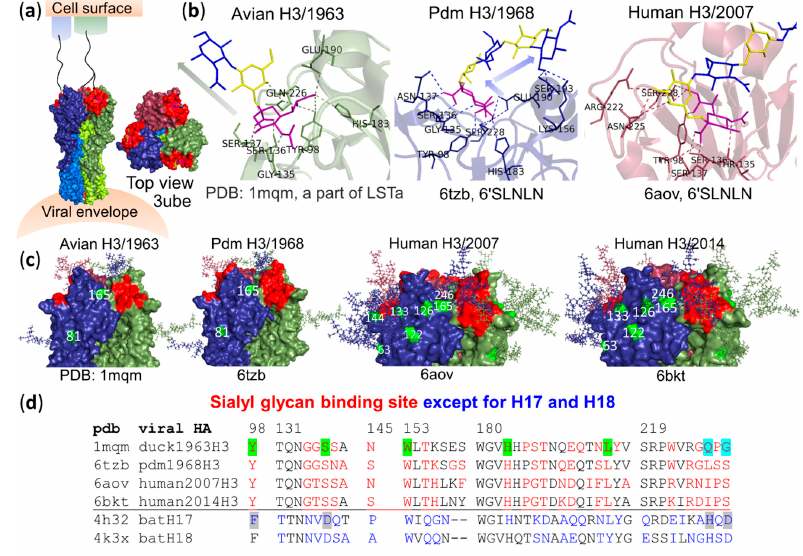
Figure 3. Binding of avian, pandemic (pdm) and seasonal HAs to specific sialyl glycans. ( a ) HA trimer binding to sialyl glycan receptors on the host cell surface. ( b ) Direct interactions in stick models between aa residues in avian / 1963 (green smudge color), pdm / 1968 (deep blue color) and seasonal / 2007 (raspberry color) H3 HA receptor binding sites and sugar residues, a part of lactoseries tetrasaccharide a (LSTa; Neu5Ac α 2,3Gal β 1,3GlcNAc β 1,3Gal β 1,4Glc), 6 (cid:48) sialyl di- N -acetyllactosamine (6 (cid:48) SLNLN; Neu5Ac α 2,6(Gal β 1,4GlcNAc) 2 ) and 6 (cid:48) SLNLN, respectively. Neu5Ac, magenta; Gal, yellow; GlcNAc, blue. ( c ) Comparison of the number of glycosylation sites (green residues) on the HA1 globular head trimer (surface diagram) between avian, pdm and seasonal H3 HAs. Glycans were in silico added into N -glycosylation sites (NXS / T, X = any residue except for Pro) on the H3 HA heads by GlyProt and are shown as sticks with organic spheres. ( d ) Alignment showing aa changes in RBS (H3 numbering). Amino acids in avian, pdm and seasonal H3 HAs and in H17–H18 HAs generating a shallow pocket are labeled red and blue, respectively. Highly conserved amino acids giving direct interactions with Sia are highlighted in green. Well-known amino acids in HA sequences that are critical for determination of the sialyl linkage-type of avian and human host cells are highlighted in cyan. 1mqm, 6tzb, 6aov and 6bkt are from [149–152], respectively. The amino acid alignments shown in this figure and in the other figures were performed by using Clustal Omega